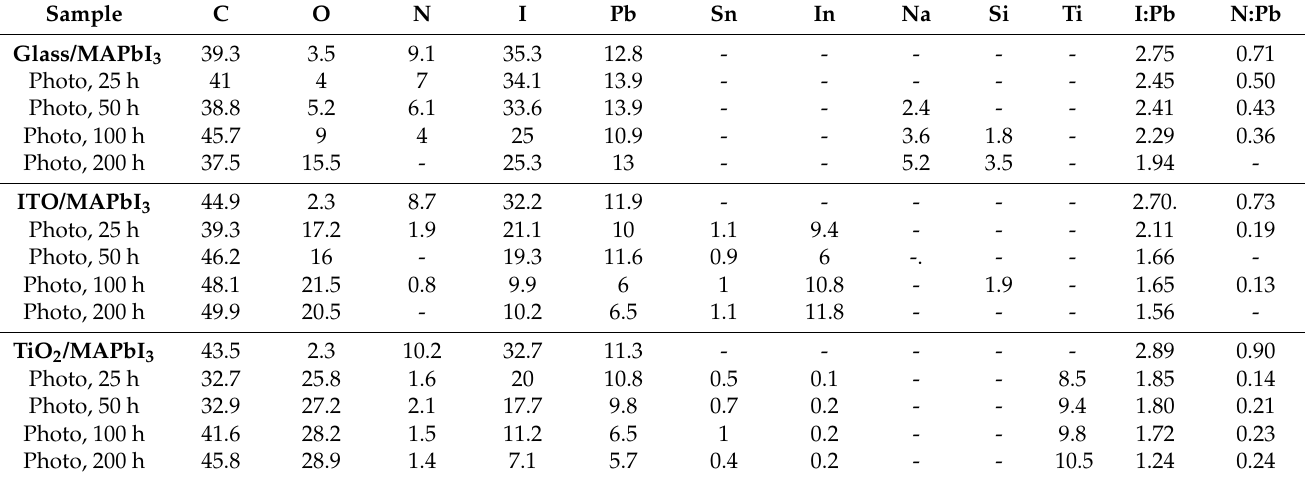
Figure 4. XPS survey spectra of light-soaked MAPbI 3 hybrid perovskites prepared on: ( a ) glass, ( b ) ITO, and ( c ) TiO 2 substrates. Table 1. Surface composition of the as-prepared and light-irradiated CH 3 NH 3 PbI 3 samples (at.